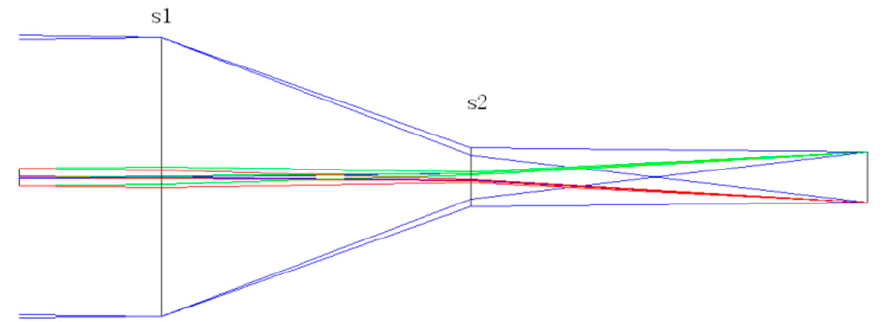
Figure 9. Optical path of the ideal system.